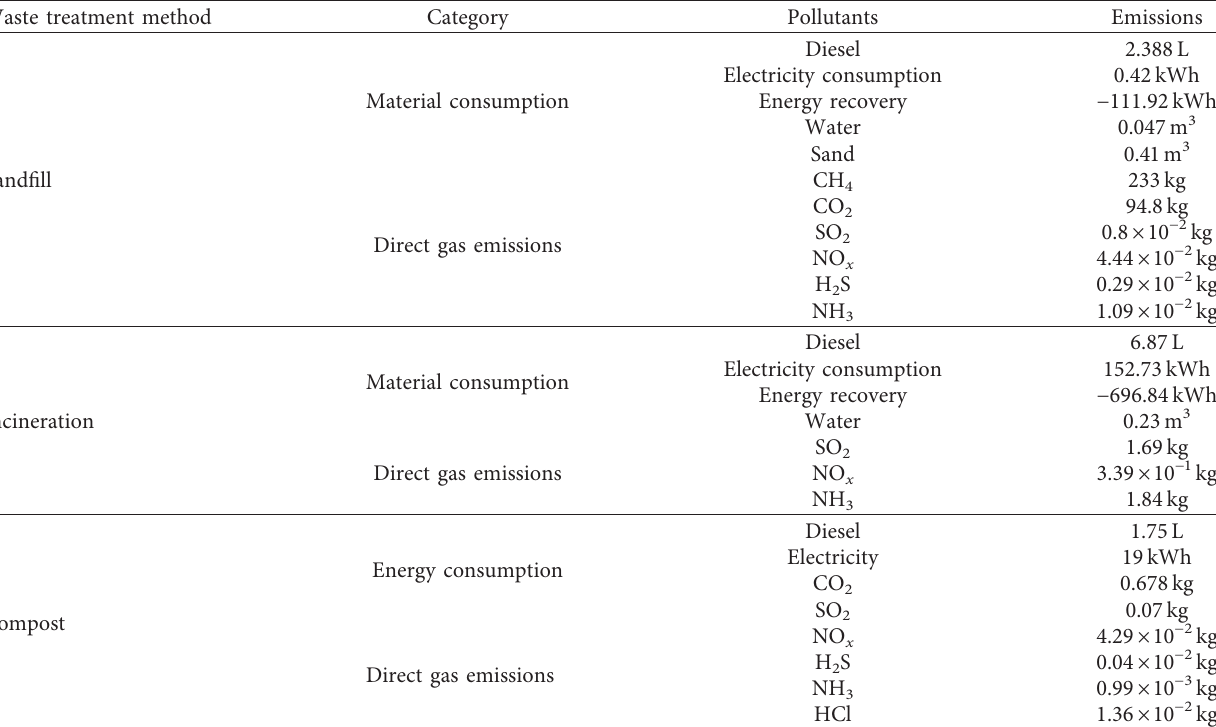
Table 5: Life cycle inventories in the operation stage of each scenario (per tonne of dry waste).